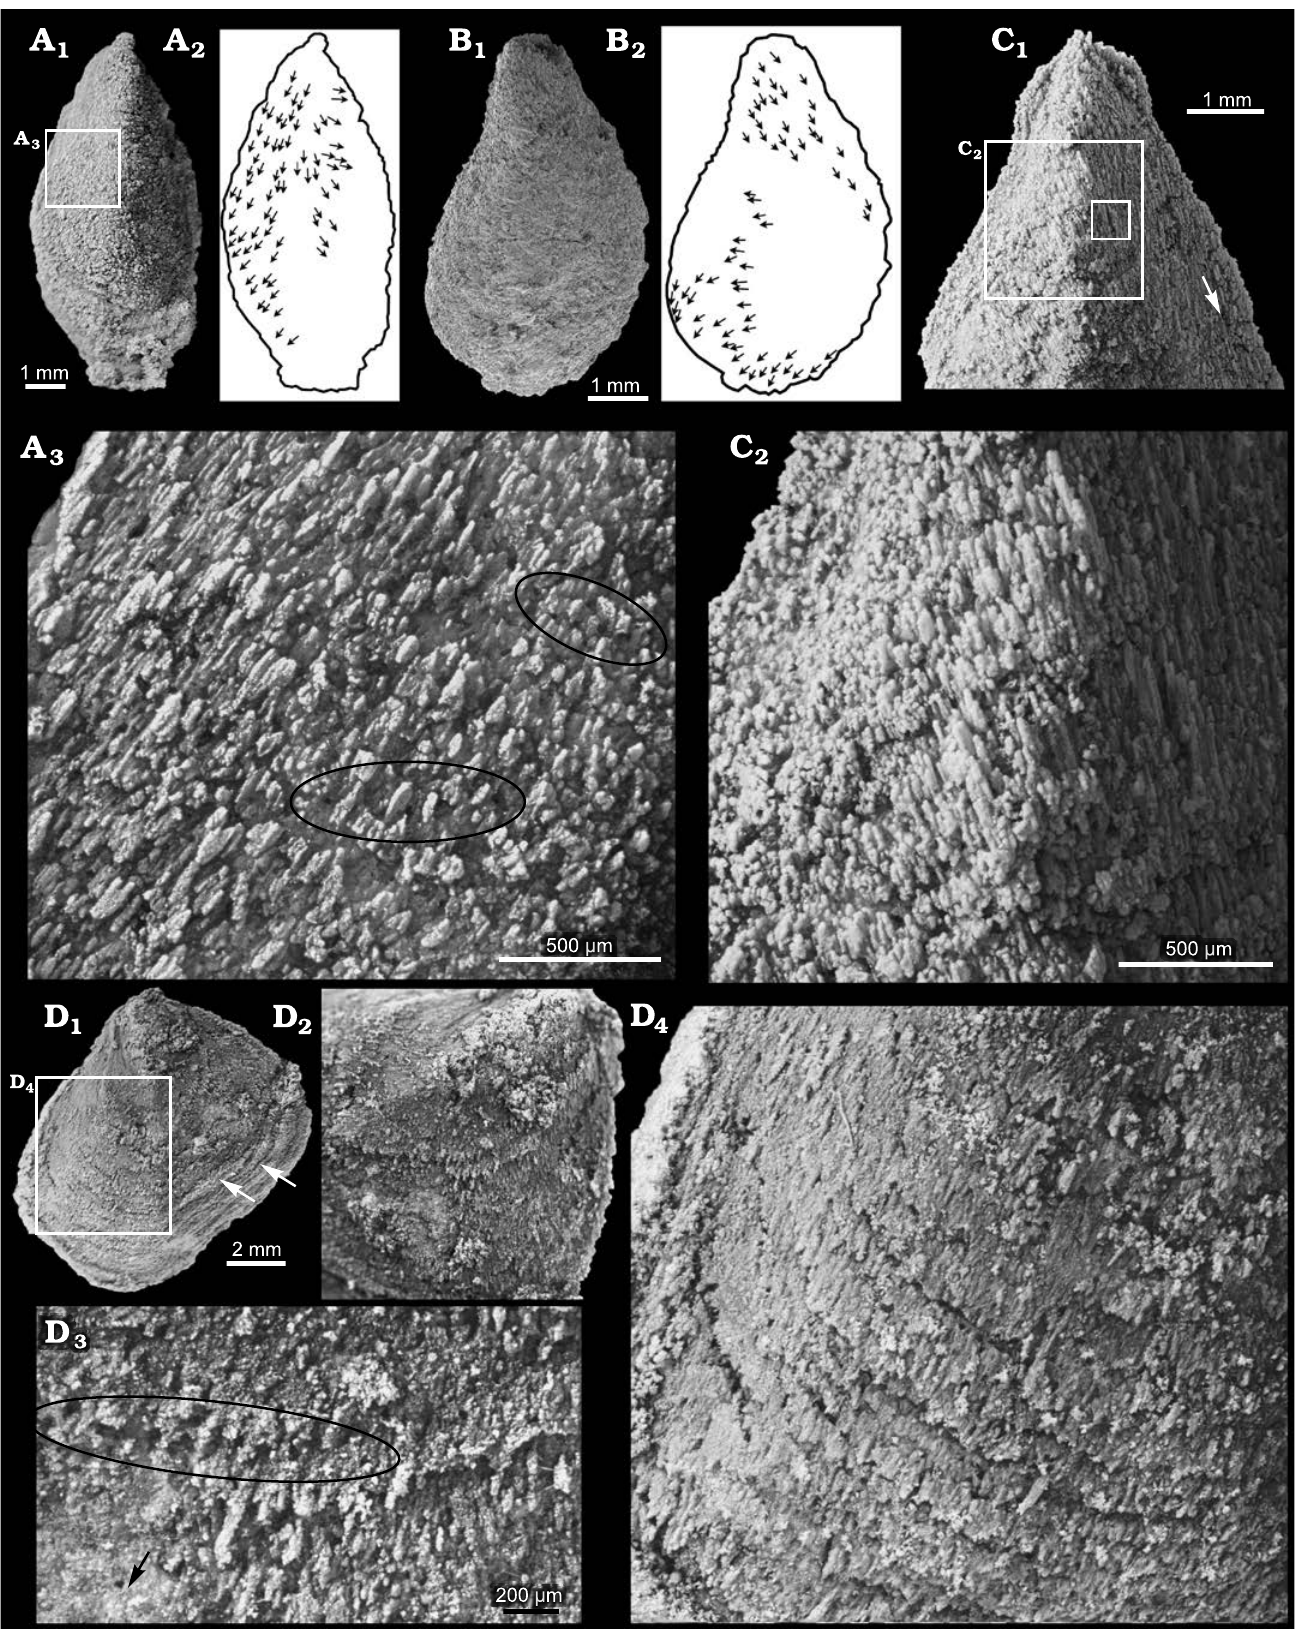
Fig. 11. Stenothecoid pan-brachiopod Stenothecoides rasettii sp. nov., middle Cambrian, Burgess Shale Formation, Yoho National Park, Canada, Locality 1. A . TMP 2008.024.1148, dorsal valve (A 1 ) and silhouette (A 2 ), with arrows showing long axes of silica rods; detail showing holes (some highlighted